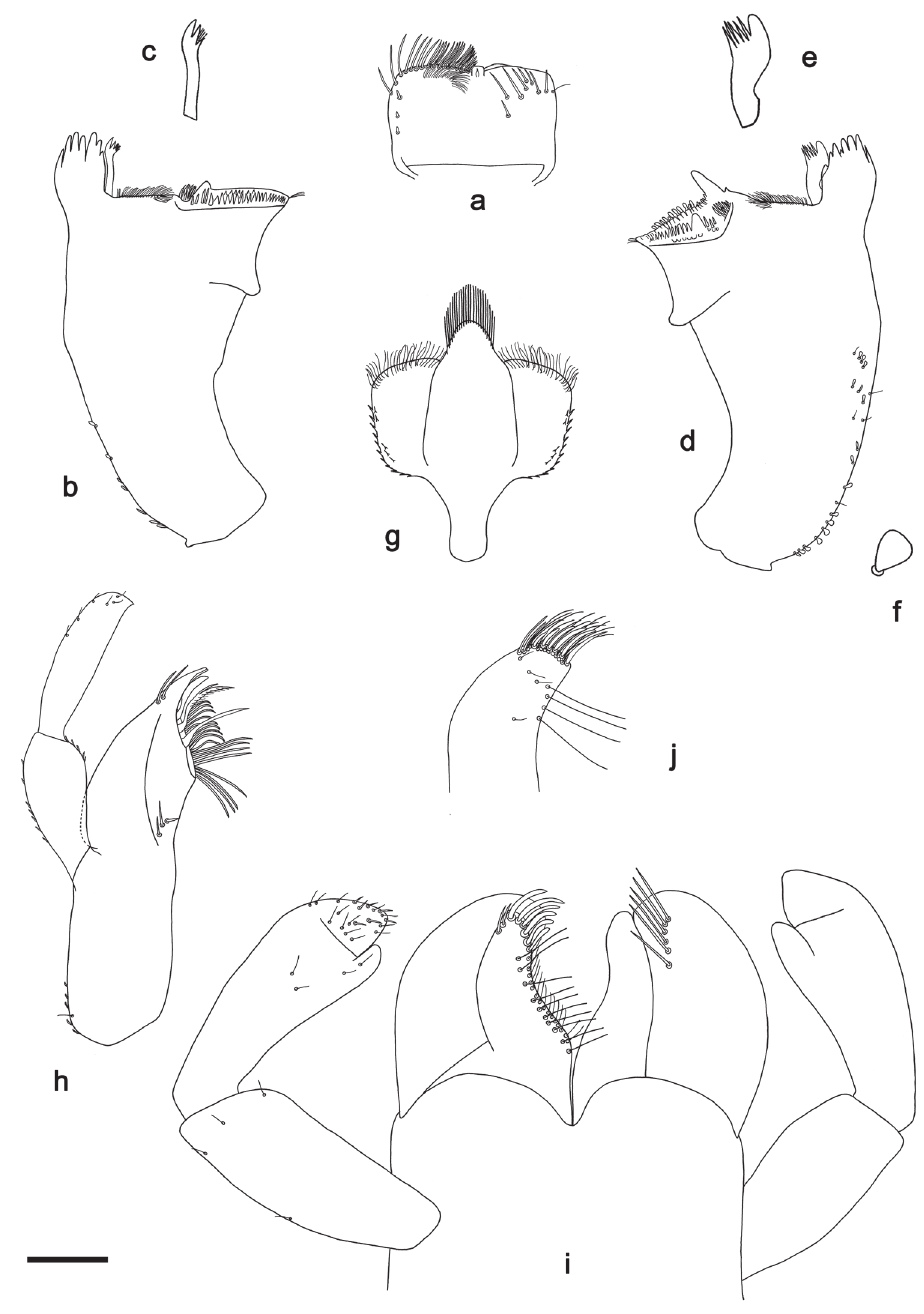
Figure 4. Pedicelliops capillifer gen. et sp. nov., larva morphology a labrum b right mandible c right pros- theca d left mandible e left prostheca f seta on left mandible g hypopharynx and superlinguae h maxilla i labium (left: ventral view, right: dorsal view) j paraglossa (ventral view). Scale bar: 0.1